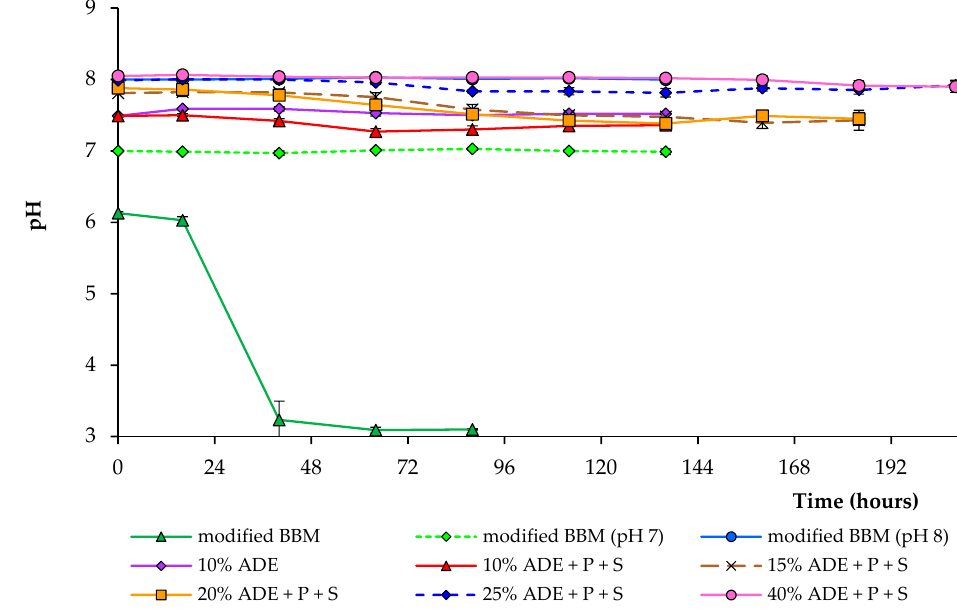
Figure 3. pH changes during the growth of C. sorokiniana AM-02 under different conditions.